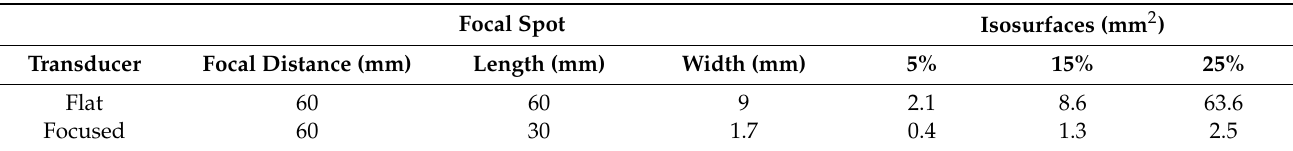
Table 2. The differences between a flat transducer and a focalized transducer. Results achieved using the developed numerical